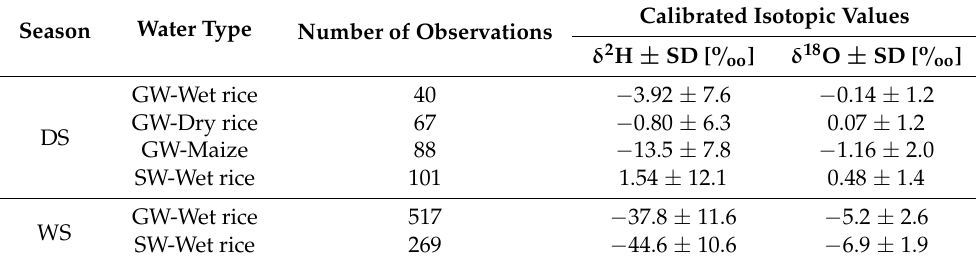
Table 1. Mean ± standard deviation (SD) and number of observations of calibrated stable isotopes of groundwater (GW) and surface water (SW) from different crops (maize, wet rice, and dry rice) during the dry season (DS) and wet season